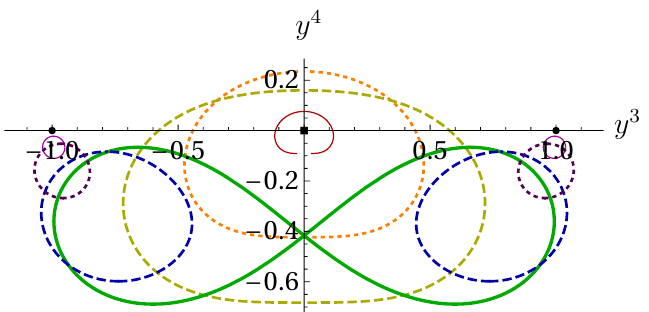
Figure 8. Cross-section of the supertube at y 1 = y 2 = 0 for di(cid:11)erent values of (cid:3) 0 . For (cid:3) 0 = 0 the supertube collapses to the k = 1 instanton con(cid:12)guration centred at the origin (denoted by a black square) that we have studied in detail in this paper. For 0 < (cid:3) 0 (cid:25) 2 : 285 the zeros of the scalar (cid:12)eld lie on a simply connected, non-self-intersecting curve (a deformed ellipse). This is illustrated by the values (cid:3) 0 = 1 = 10 (thin, red, continuous curve), (cid:3) 0 = 1 = 2 (orange, dotted curve) and (cid:3) 0 = 1 (yellow, dashed curve). At (cid:3) 0 (cid:25) 2 : 285 (thick, green, continuous curve) this curve pinches o(cid:11). For 2 : 285 . (cid:3) 0 < 1 the zeros of the scalar (cid:12)eld lie on two disconnected curves, as illustrated by the values (cid:3) 0 = 3 (blue, dashed curve), (cid:3) 0 = 8 (purple, dotted curve), and (cid:3) 0 = 20 (thin, magenta, continuous curve). For (cid:3) 0 ! 1 these two curves collapse to two points denoted by the black circles on the y 3